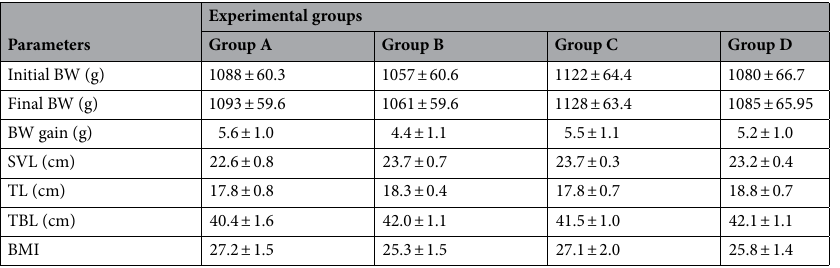
Table 1. The morphometric measurements in the different experimental groups of Dabb lizard ( U. aegyptia ). Data are expressed as mean ± SE. SVL Snout-vent, TL Tail length, TBL Total body length, BMI Body-mass- index, Group A Control group, Group B Low temperature exposed group, Group C Moderate temperature exposed group, Group D High temperature exposed group, BW Body